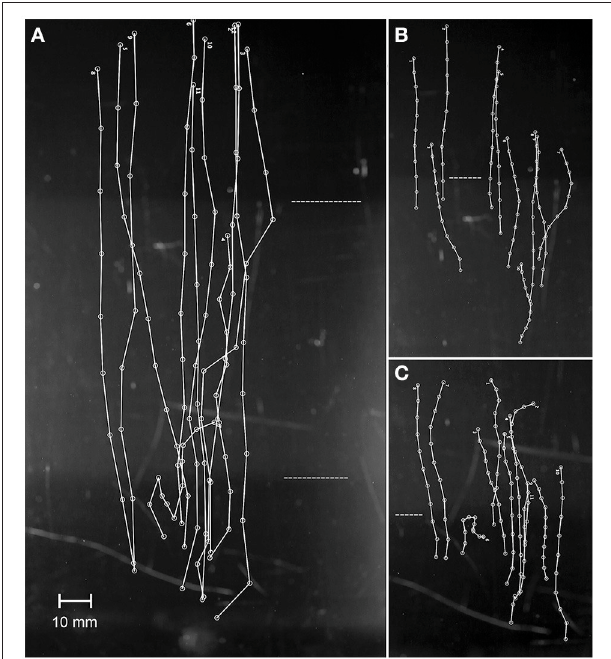
FIGURE 6 | The response of planulae to haloclines, the first trial of two in 2015. Larvae were video recorded shortly after being introduced near the bottom of the aquarium. (A) The complete trajectories from the full video sequence (222s). (B) Trajectories from the gradient between middle and top layer (60s). (C) Trajectories from the gradient between bottom and middle layer (60s). The dashed horizontal lines indicate the haloclines. Visual frame in A = 107.4 ×